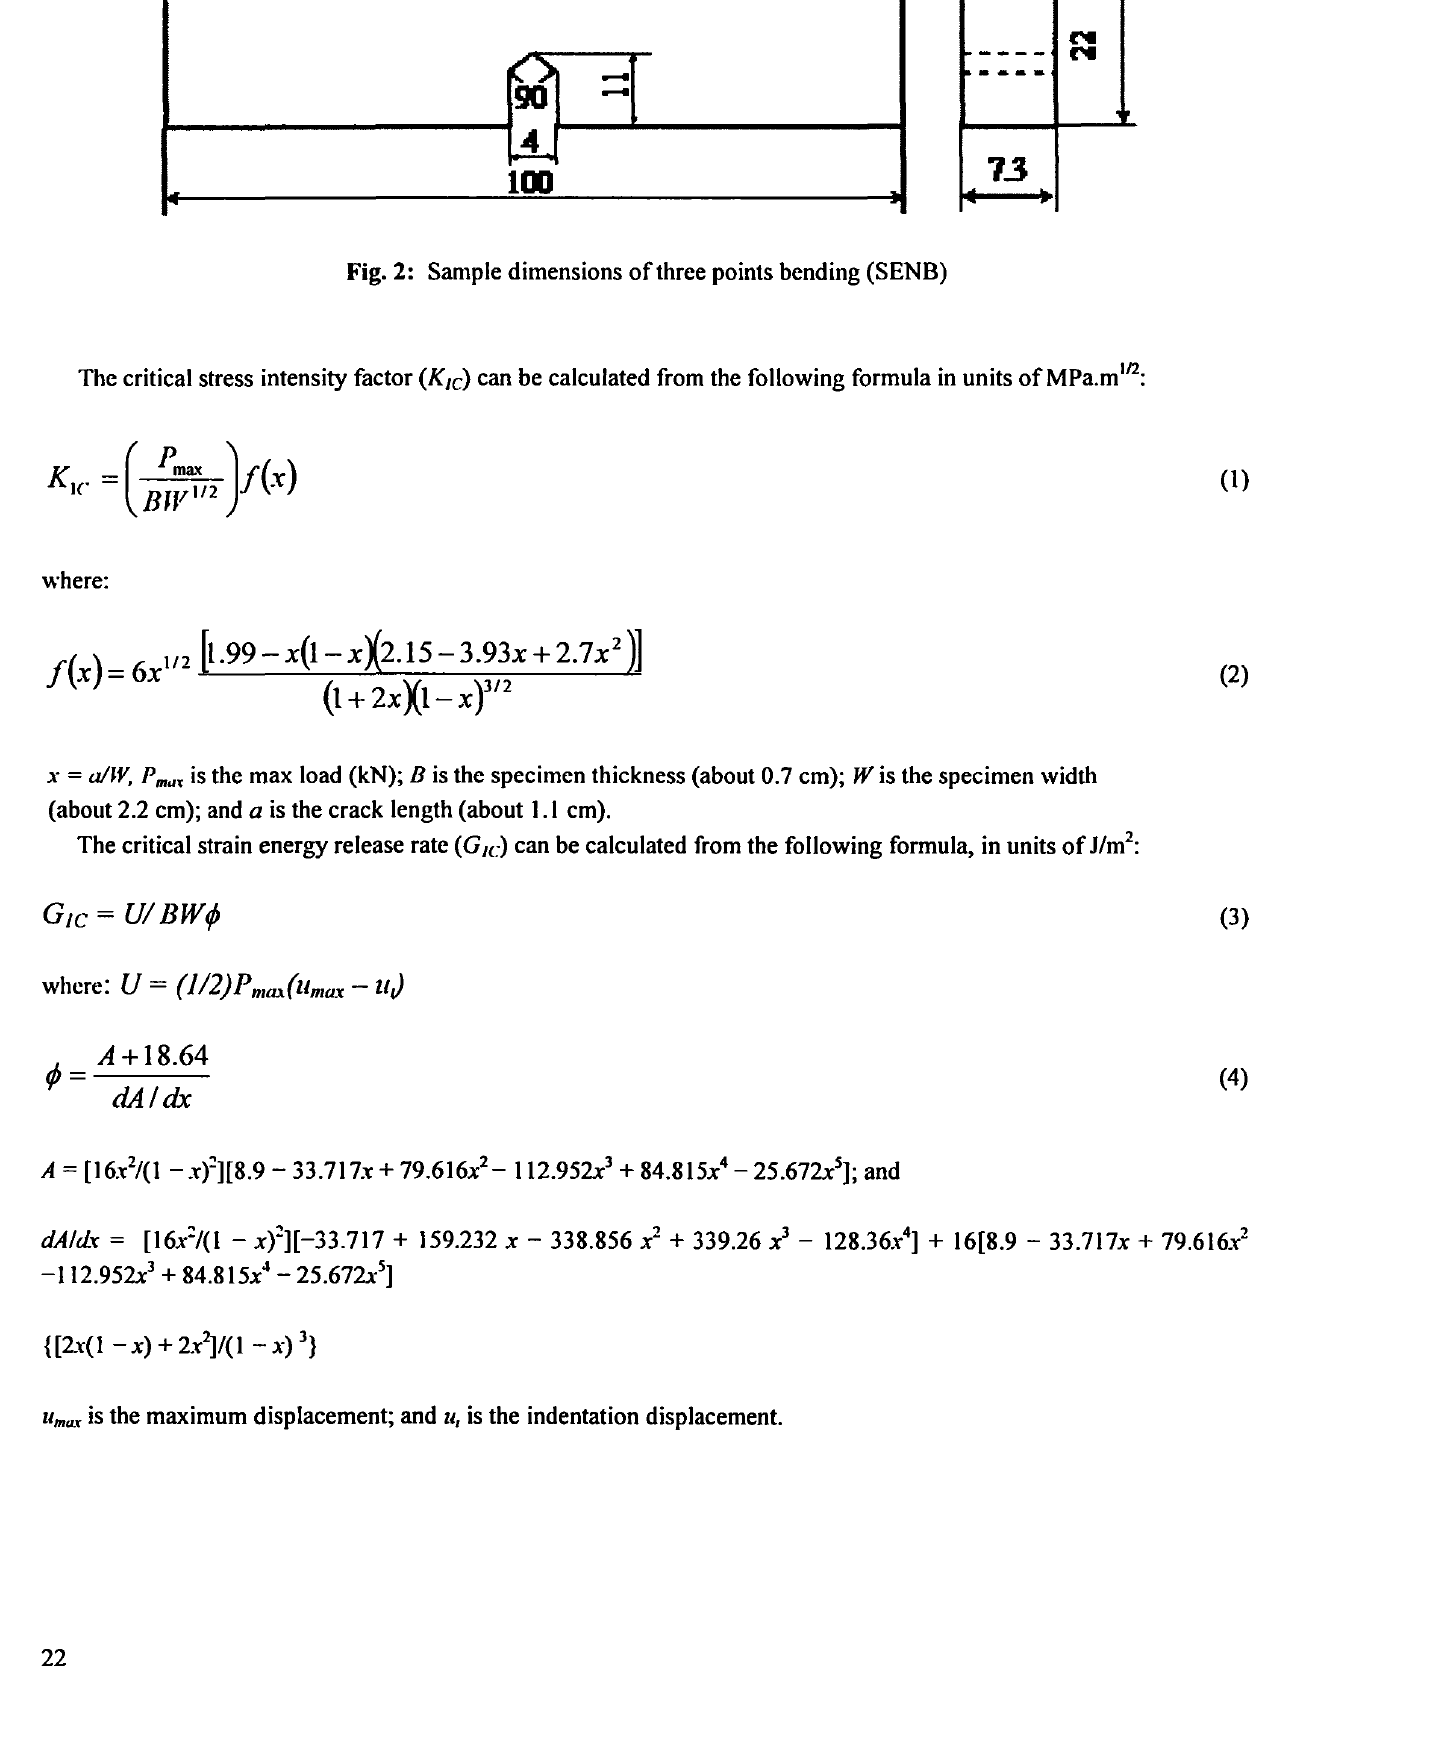
Fig. 2: Sample dimensions of three points bending